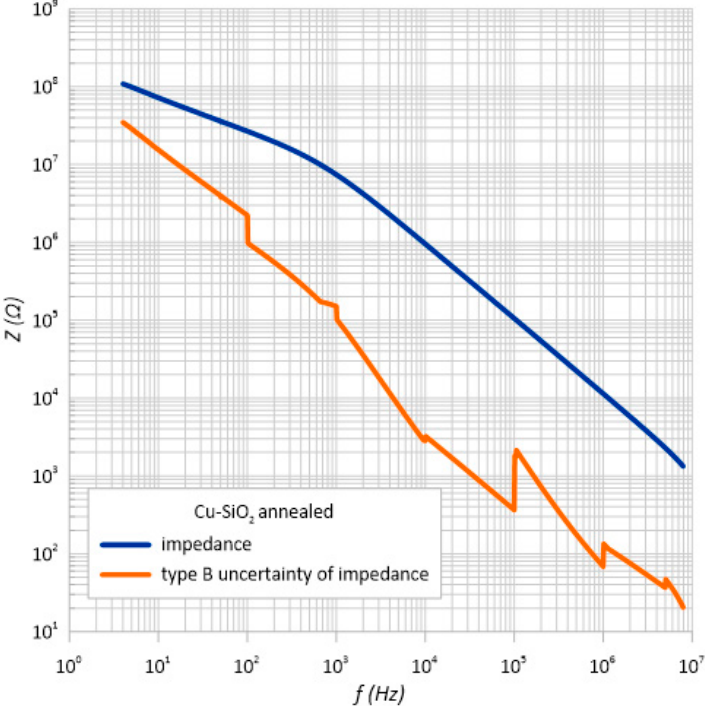
Figure 13. Frequency dependence of the impedance and standard impedance uncertainty of mea- surement type B u ( Z ) of the heated structure.